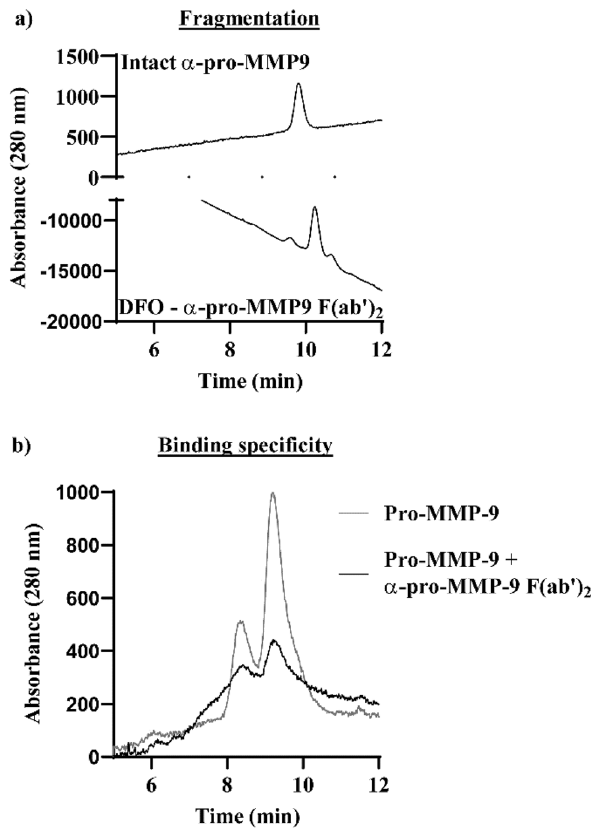
Figure 4. ( a ) α-pro-MMP-9 F(ab ′ ) 2 fragments had a longer retention time than intact antibody and ( b ) specifically bound